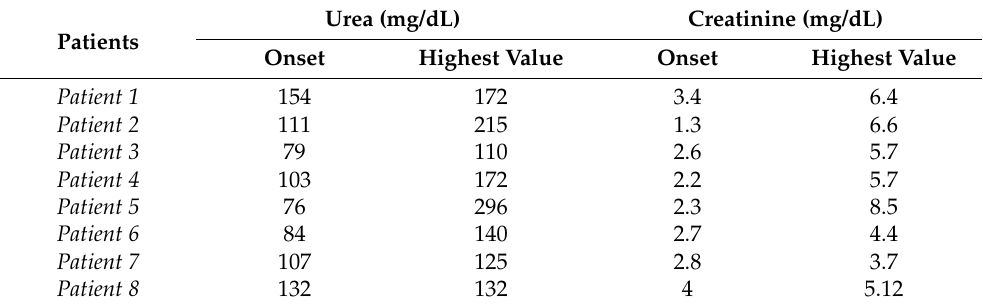
Table 2. Urea and Creatinine Values at onset versus highest value during